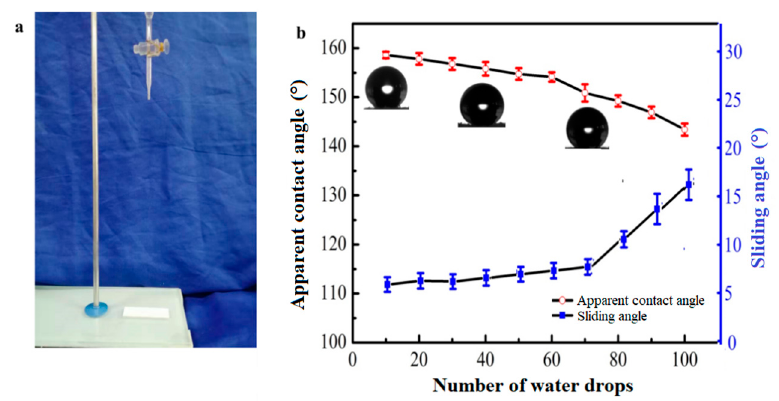
Figure 9. ( a ) The device used for an impact resistance test; ( b ) the change of apparent contact angle and sliding angle after water impact.